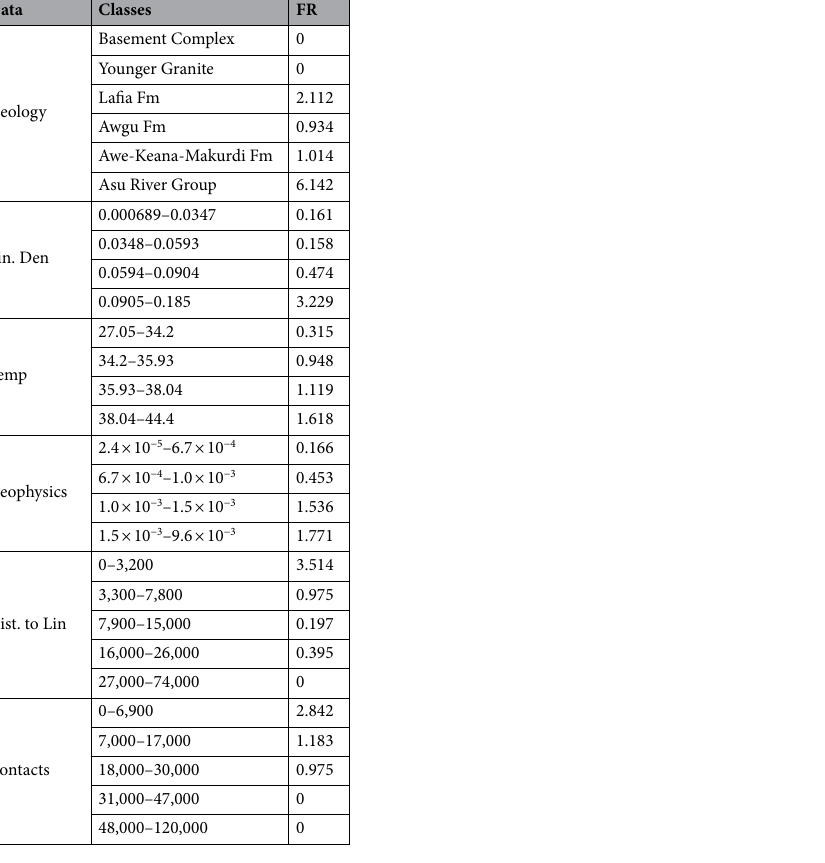
Table 3. Parameter weighting by application of frequency